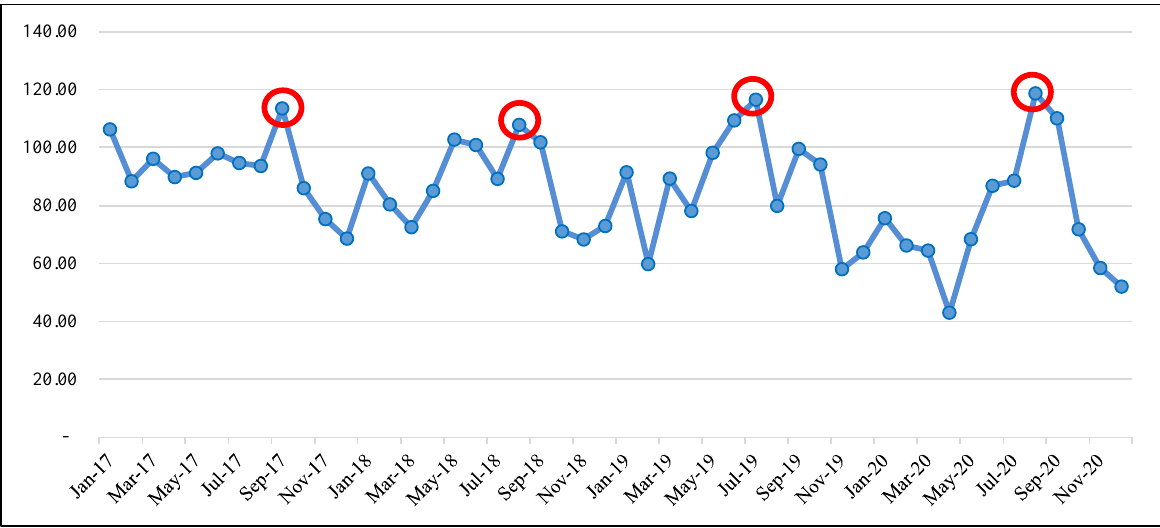
Figure 4. The rate of food poisoning incidence per 100,000 elderly people in Roi Et Province at 4 epidemic peaks selected for the model analyses.